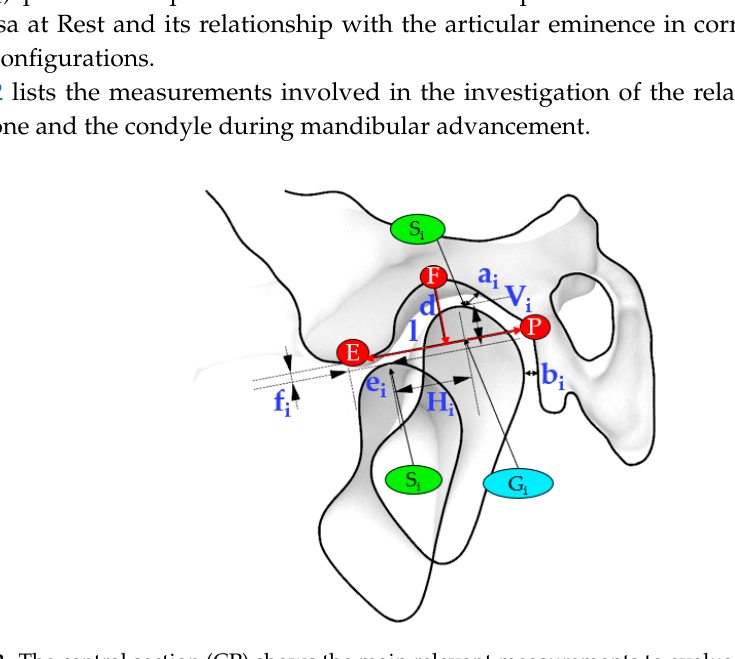
Figure 3. The central section (CP) shows the main relevant measurements to evaluate the movement of the condyle during the mandibular advancement. Main relevant measurements that are useful for investigating the TMJ